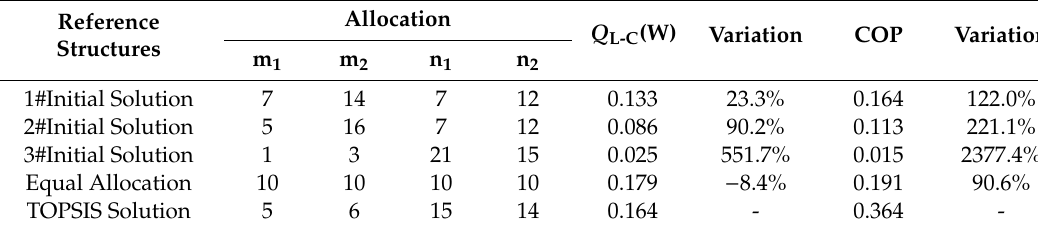
Table 4. Parameters and performances comparison between the Initial Solutions, Equal Allocation, and TOPSIS